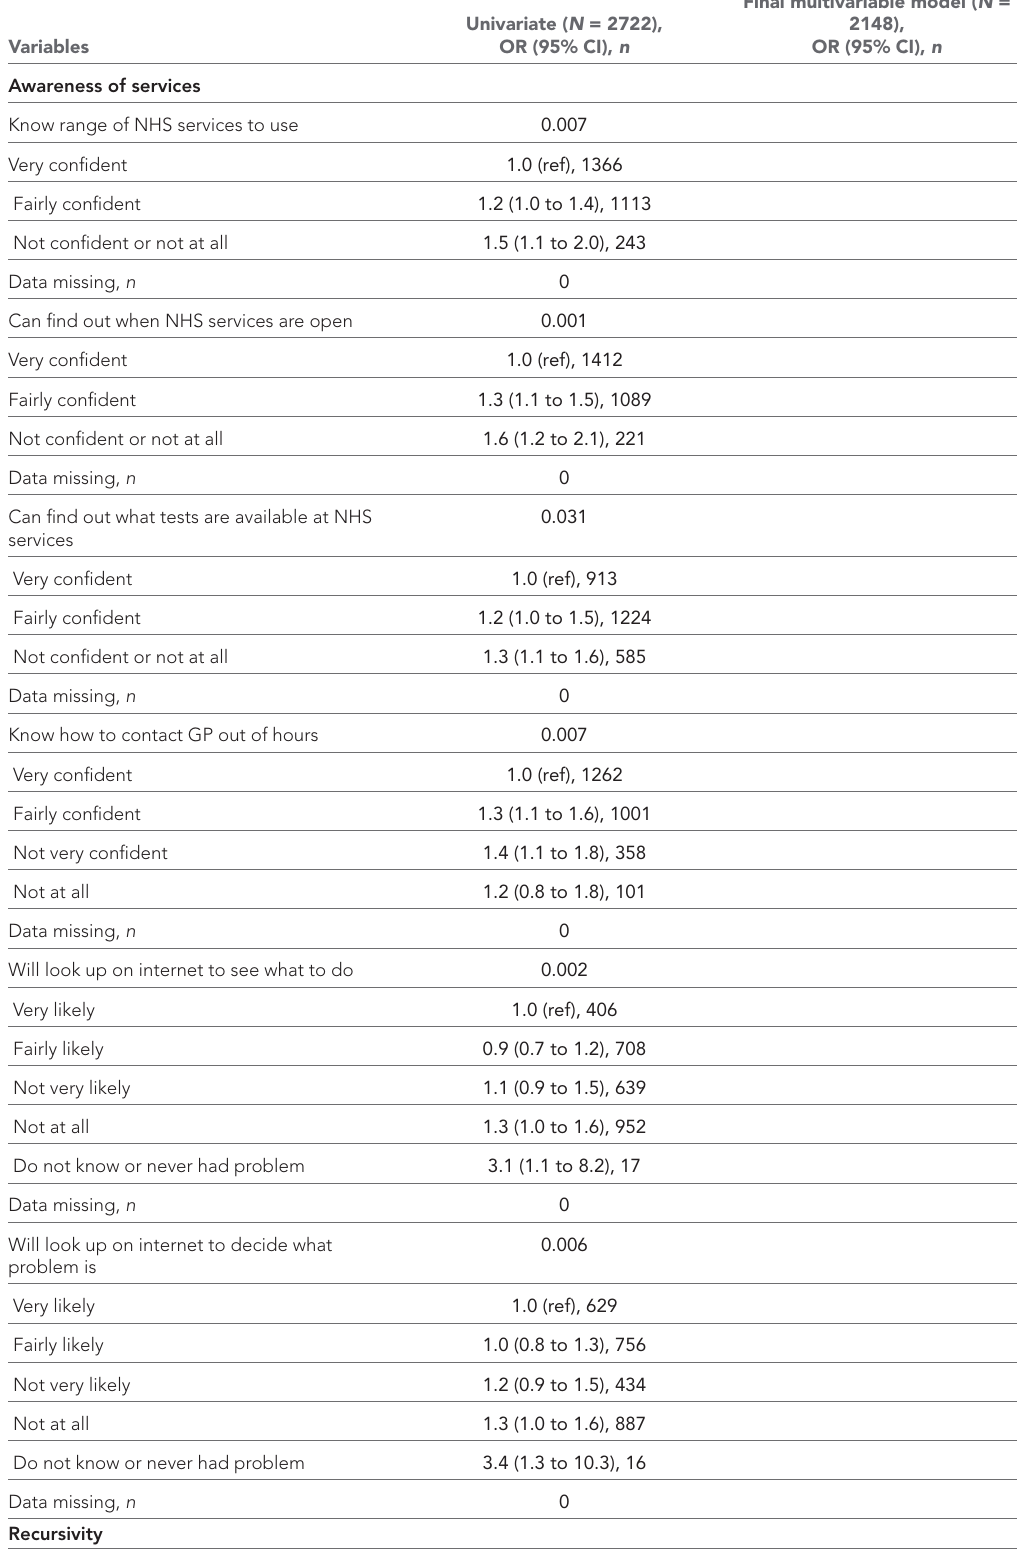
Table 6 Factors measuring other issues from literature: association with tendency to contact GP rath- er than self- care for minor